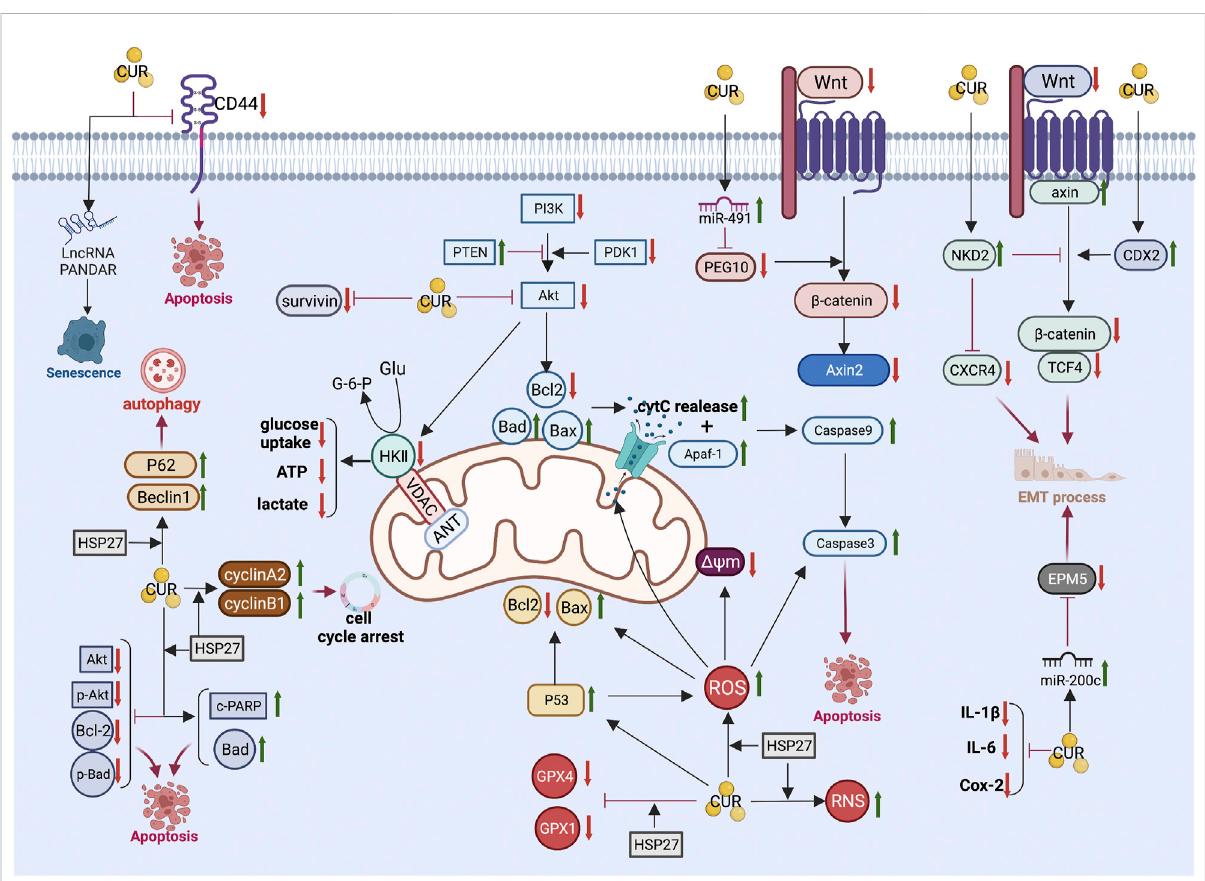
FIGURE 3 Pharmacologicalmechanismunderlyingtheeffectsofcurcuminoncolorectalcancer(CreatedwithBiorender.com).LncRNA,longnon-coding RNA;PI3K,Phosphatidylinositol3-kinase;Akt,ProteinkinaseB;PTEN,phosphataseandtensinhomolog;PDK1,phosphoinositide-dependentprotein kinase-1; Bcl2, B-cell lymphoma 2; Bax, B-cell lymphoma-2 (Bcl-2)-associated X protein; Bad, BCL2 associated agonist of cell death; cytC, cytochrome C; Δψ m, mitochondrial membrane potential; Apaf-1, Apoptotic protease activating factor 1; PEG10, paternally expressed gene 10; Axin2,axisinhibitionprotein2;NKD2,Nakedcuticlehomolog2;CXCR4,chemokinereceptor4;CDX2,caudaltypehomeobox2;TCF4,transcription factor 4; EMT, epithelial-mesenchymal transition; IL-6, interleukin-6; IL-1 β , interleukin-1 β ; Cox-2,cyclooxygenase-2; ROS, reactive oxygen species; RNS, reactive nitrogen species; HSP27, Heat shock protein 27; GPX4, Glutathione peroxidase 4; GPX1, Glutathione peroxidase-1; c-PARP, cleaved poly (ADP-ribose) polymerase;